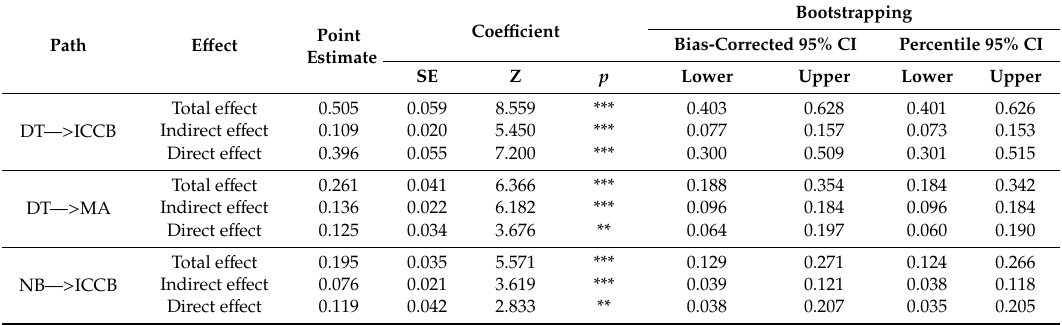
Table 4. The test of indirect e ff ects (Bootstrapping times = 2000, N = 1453).